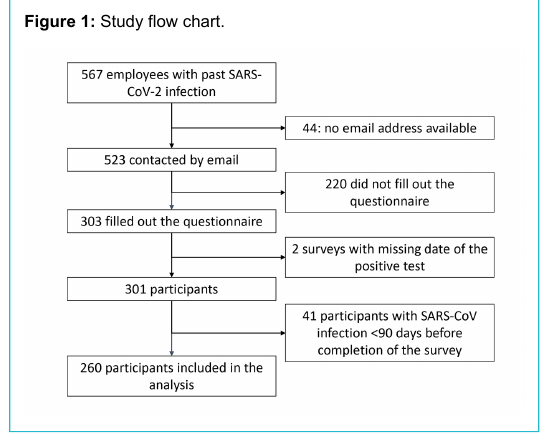
Figure 1: Study flow chart.